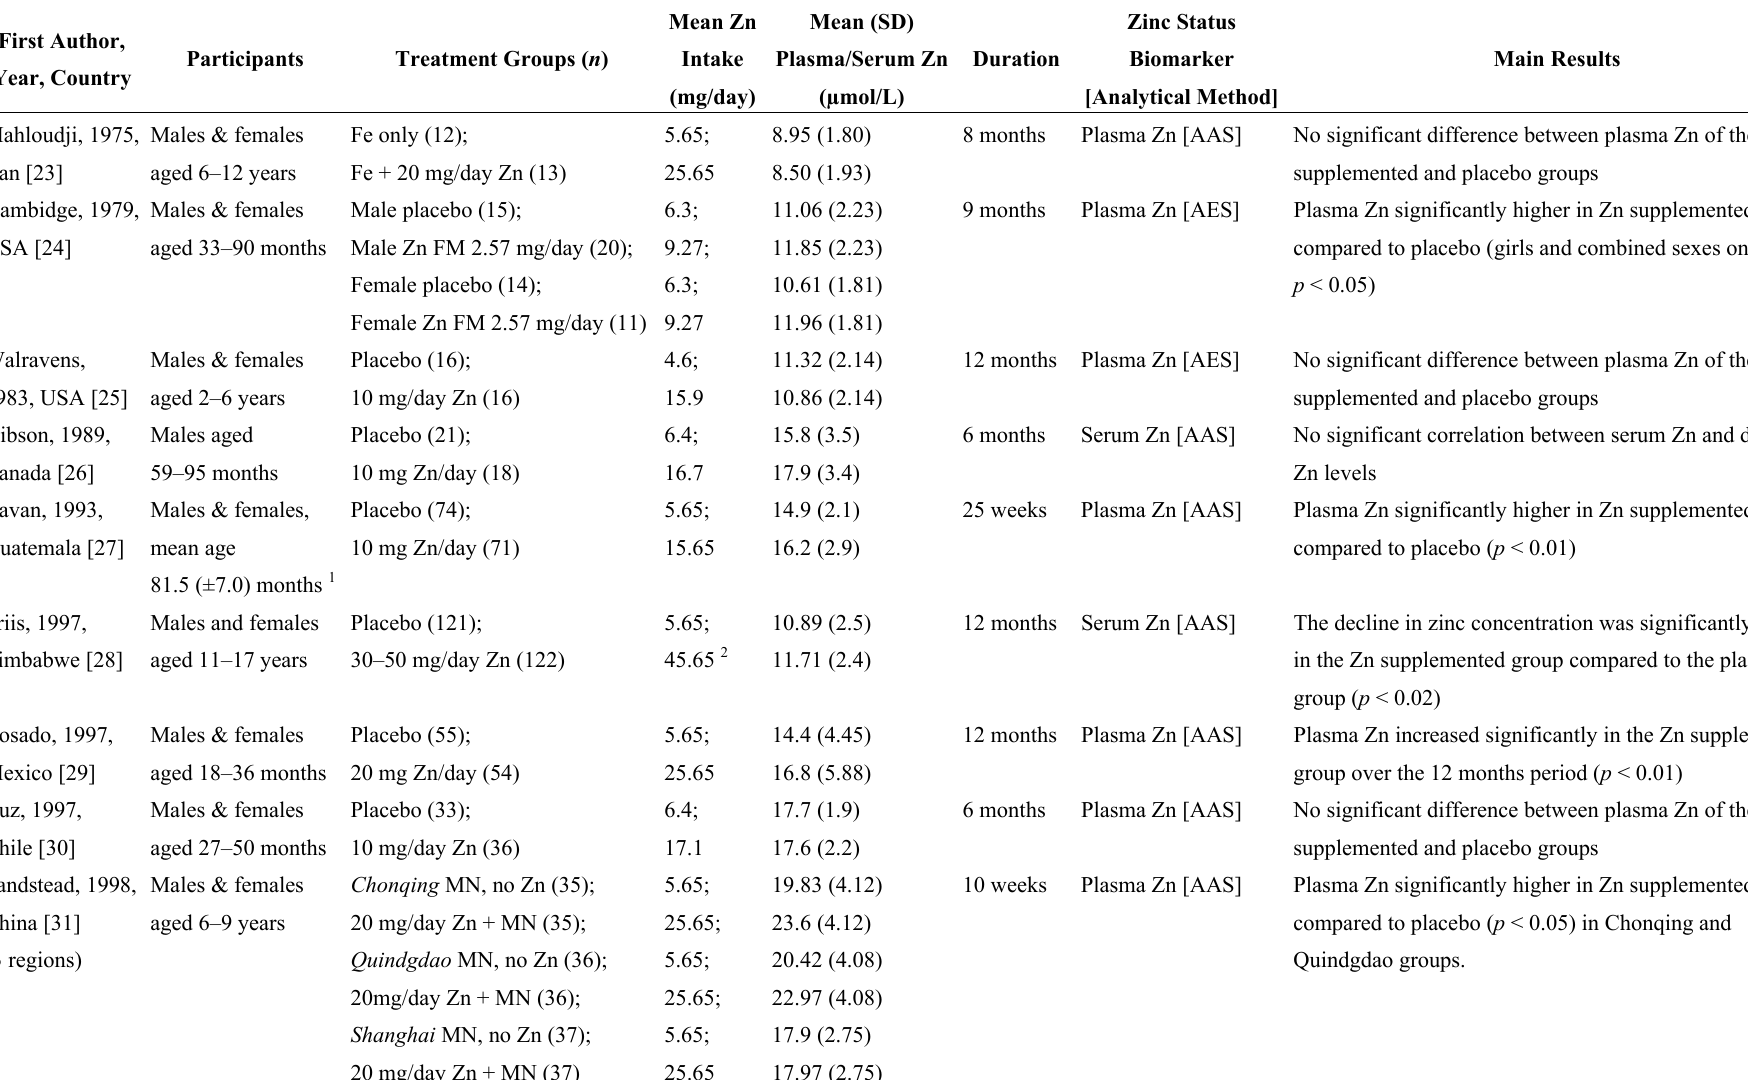
Table 2. Summary of included trials reporting the effect of dietary zinc intake on serum/plasma zinc status in